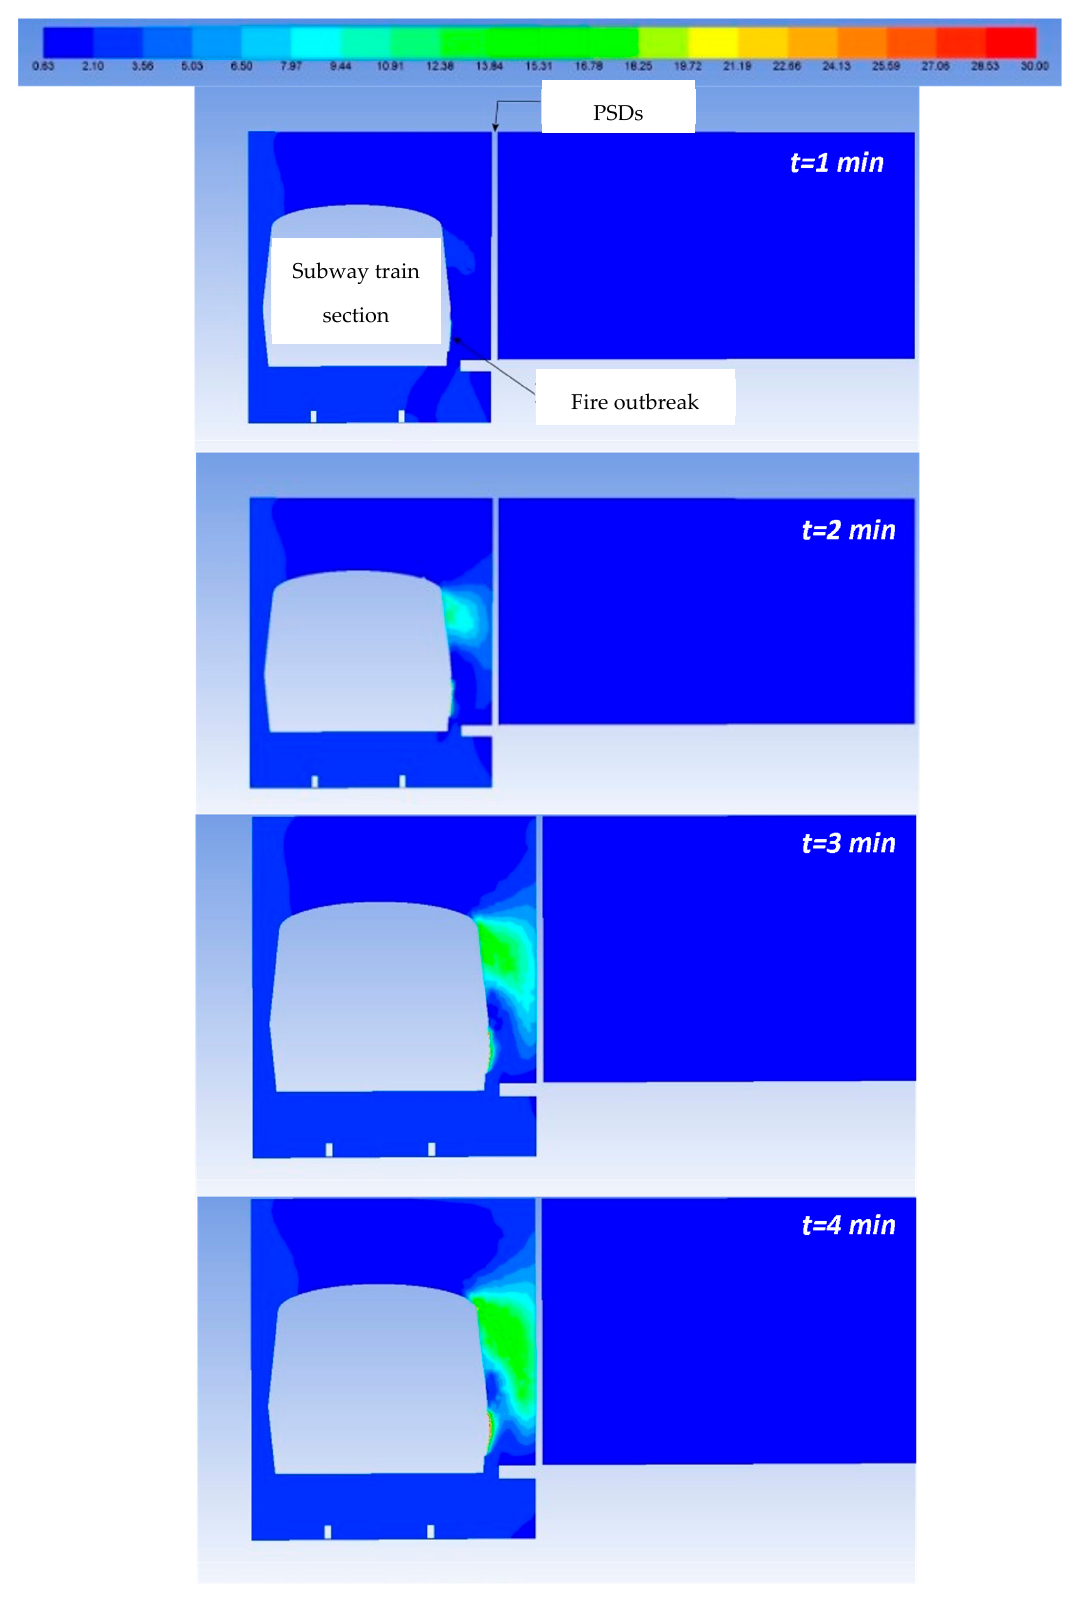
Figure 14. CO contours (ppm)—cross section through the fire outbreak (minutes 1–4).